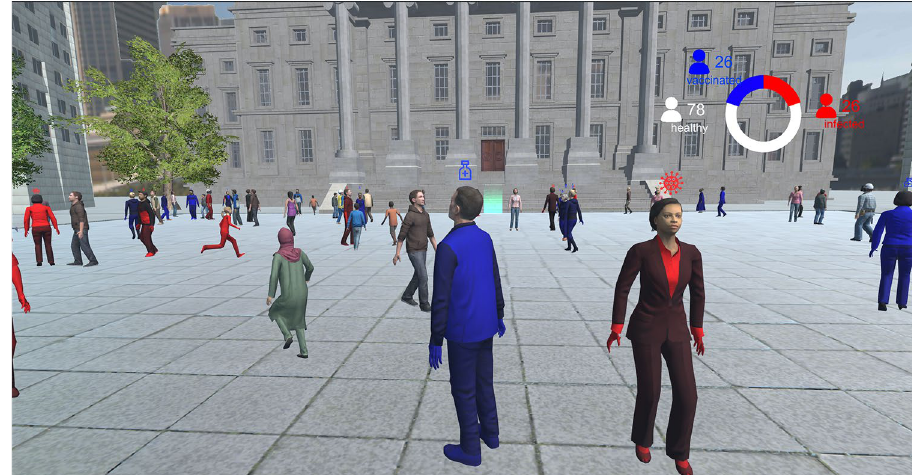
Figure 2. The busy square scene in VR, with feedback graph showing the number of infected, healthy and vaccinated